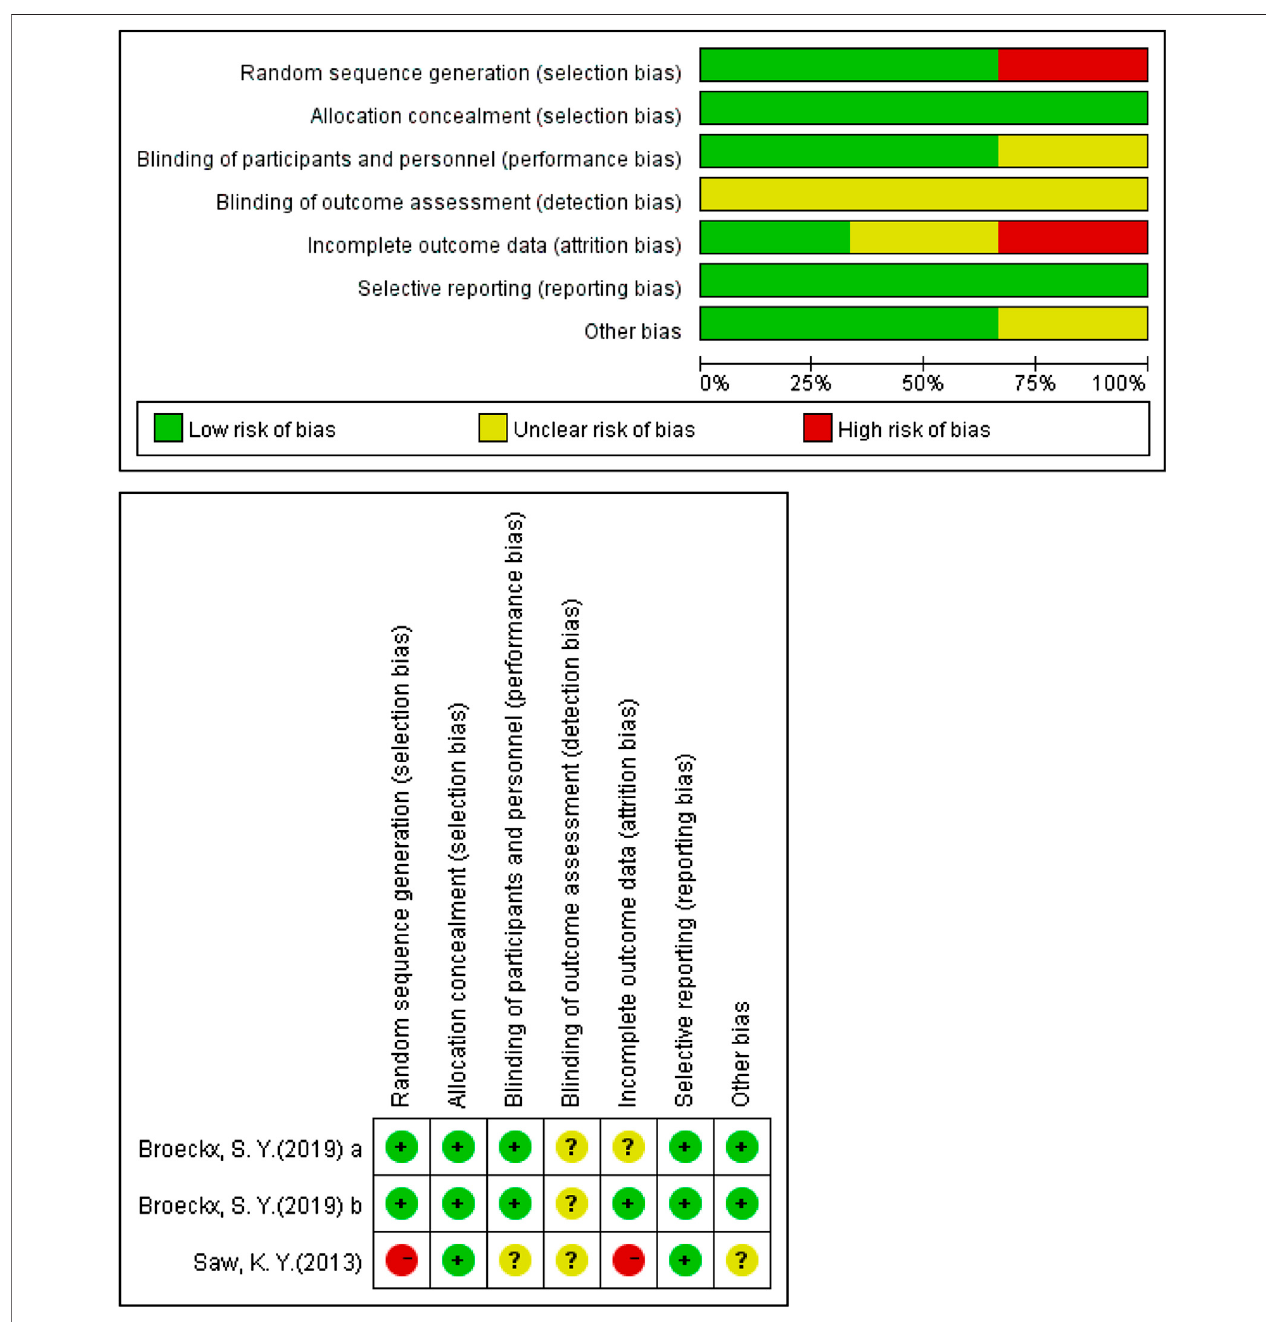
FIGURE 4 | Risk of bias with